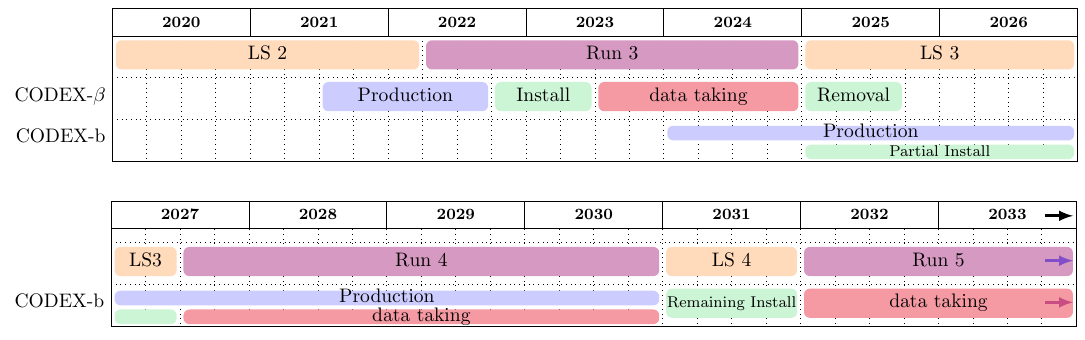
Fig. 2 Approximate production, installation and data-taking timelines for demonstrator (CODEX- β ) and full (CODEX-b) detectors. (Updated according to COVID